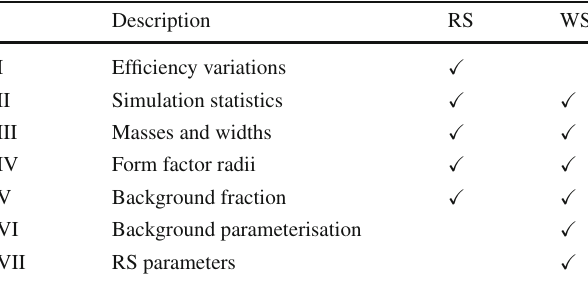
Table 13 Legend for systematic uncertainties, including whether this sources of uncertainty is considered on the RS/WS decay mode